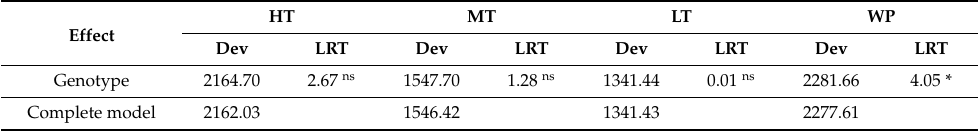
Table 1. Analyses of deviance (ANADEV): deviance (Dev) and likelihood-ratio test (LRT) for geno- types’ effects and complete model for quantification of Polyphagotarsonemus latus in 36 common bean genotypes in the three thirds of the plant: higher (HT), medium (MT) and lower (LT) and sum of the whole plant